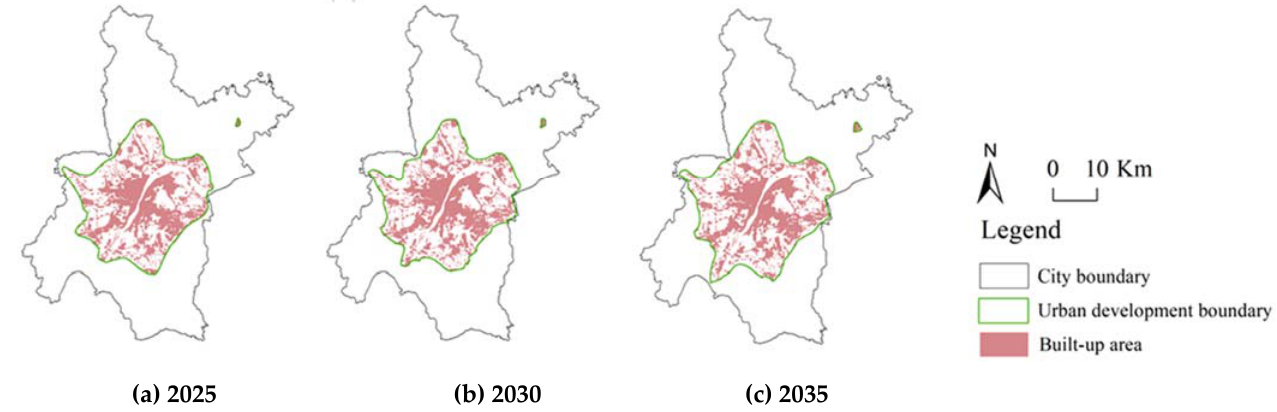
Figure 11. Hybrid urban development boundary of Wuhan city in ( a ) 2025, ( b ) 2030, and ( c ) 2035.